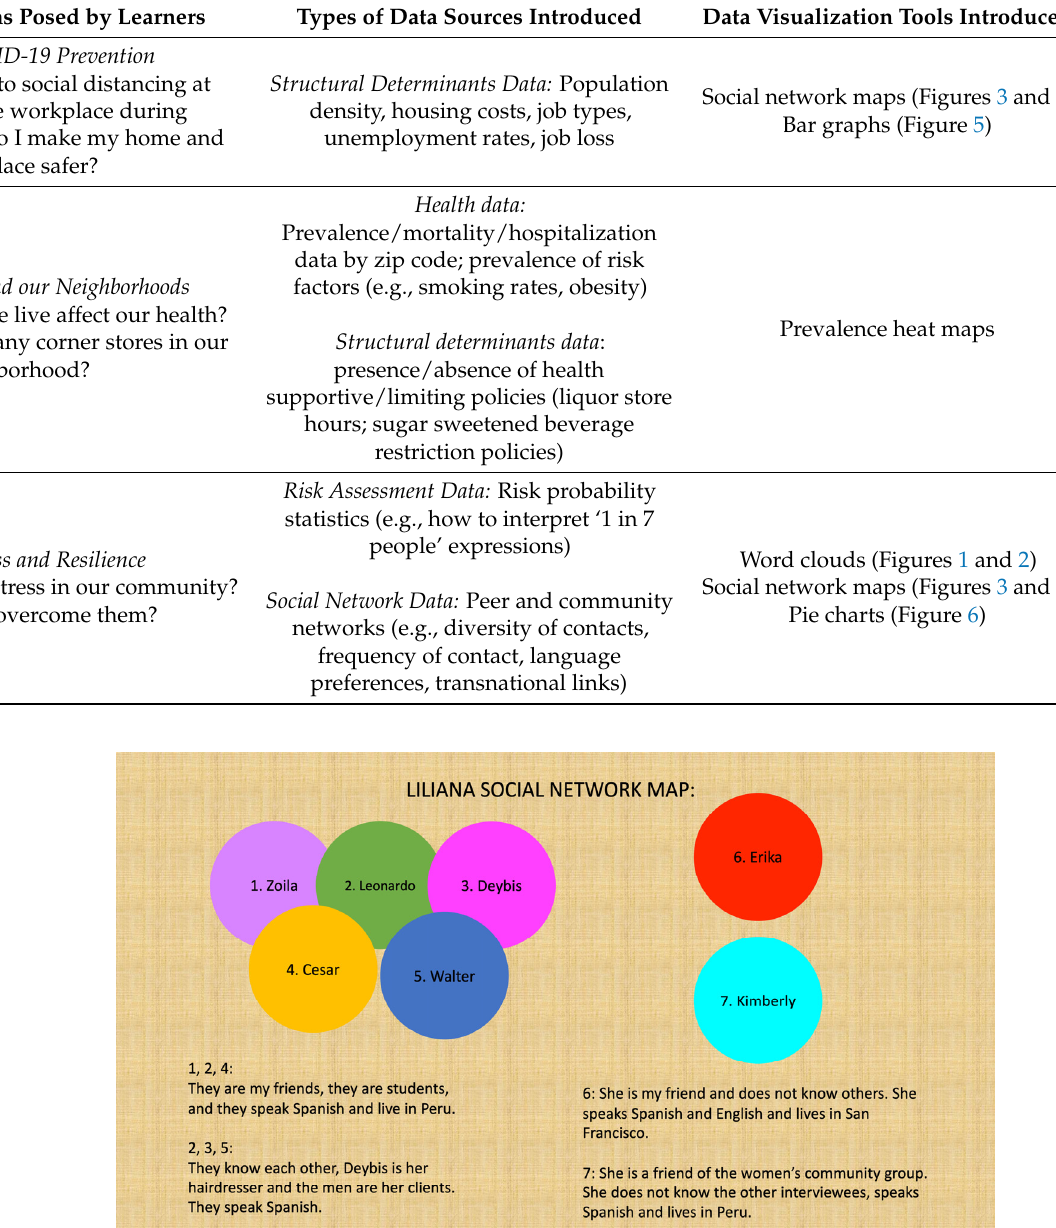
Figure 4. Depiction of a learner’s social network as emanating from herself at the center, even as each name reveals they do not live nearby. Names have been changed to preserve confidentiality.